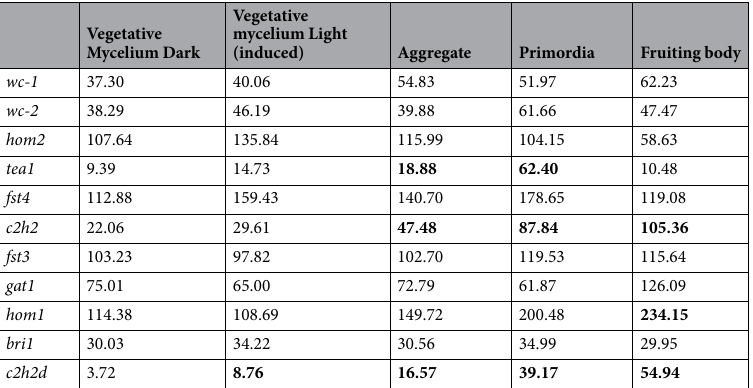
Table 1. Temporal expression of the blue light sensor gene wc-1 and transcription factor genes involved in fruiting body development in the wild-type dikaryon based on biological duplicates. Values are expressed in FKPM. Bold font indicates a significant ≥ 2-fold up-regulation when compared to dark grown vegetative